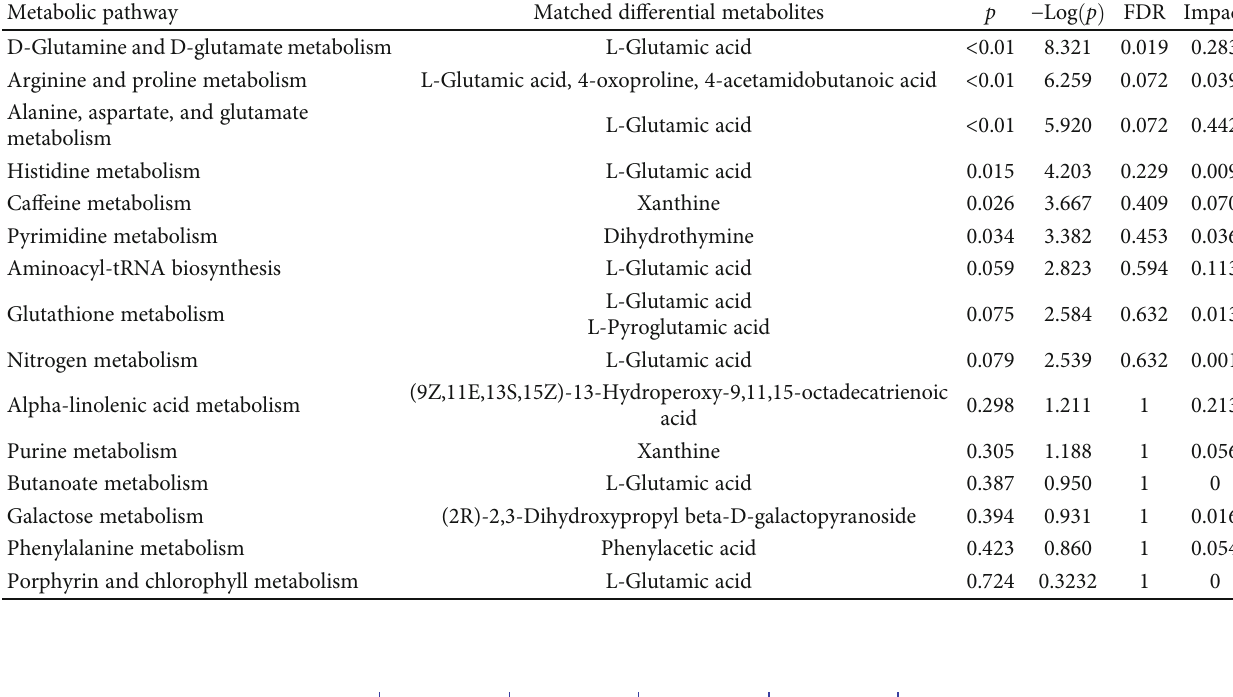
Table 3: Results of KEGG enrichment analysis of the metabolic pathways related to GDM.